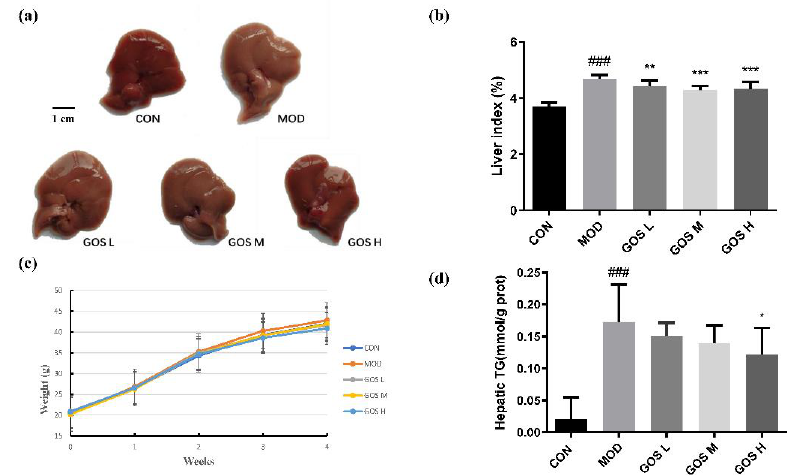
Figure 3. Liver appearance, liver index, weight change graph, and liver TG content for each group. ( a ) The appearance of the livers of mice in each group. ( b ) The effect of GOS on the liver index in mice with alcohol-induced liver injury ( n = 10, means ± SD). ( c ) The effect of GOS on mouse BW ( n = 10, means ± SD). ( d ) Hepatic TG ( n = 10, means ± SD). Notes: Compared with the MOD group, * p < 0.05, ** p < 0.01, and *** p < 0.001; compared with the CON group, ### p < 0.001. H&E staining was performed on liver sections. Fat was dissolved in a fat-soluble re- agent, and vacuoles of varying sizes were observed in the locations where the fat had been